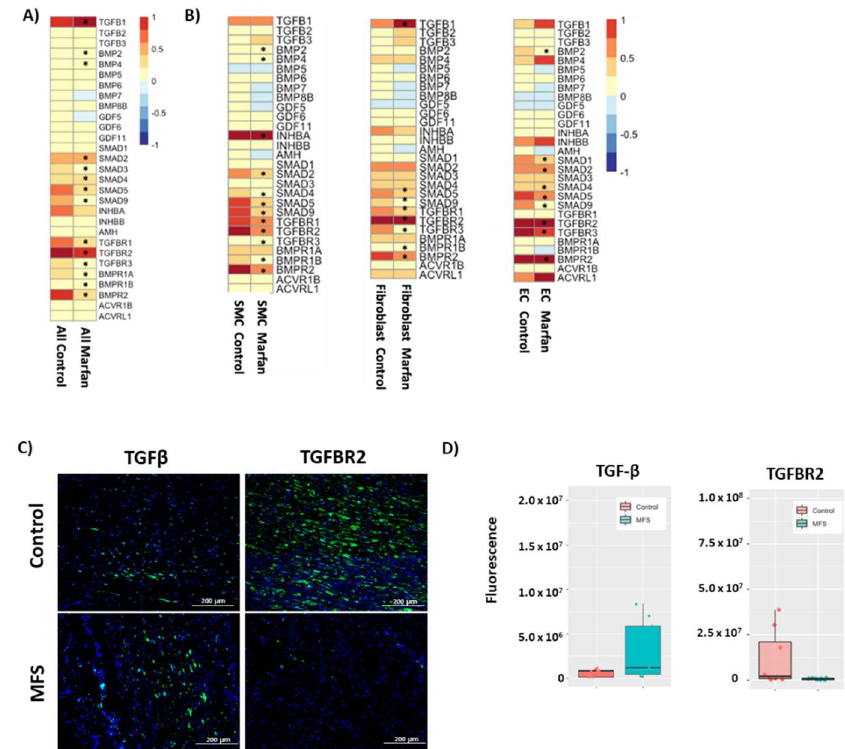
Figure 5. Global analysis of genes involved in the TGF- β pathway. ( A ) Differential gene expression in all combined immune and non-immune cells in MFS and control tissues. ( B ) Differential expression of genes encoding TGF- β ligands and receptors in overall cell populations in MFS and control samples in smooth muscle cells (SMCs), fibroblasts, and endothelial cells (ECs). Data are presented as RNA average. ( C ) Immunofluorescence of TGF- β 1 and TGFBR2 expression throughout tissue samples, to mimic combined analysis in 4A. ( D ) Quantification of immunofluorescence results reveal increased TGF β -1 but decreased levels of TGF- β receptor II in MFS compared to control tissues. Quantification was performed using unaltered images of 3 separate sections of slides from 3 controls and 3 patients with